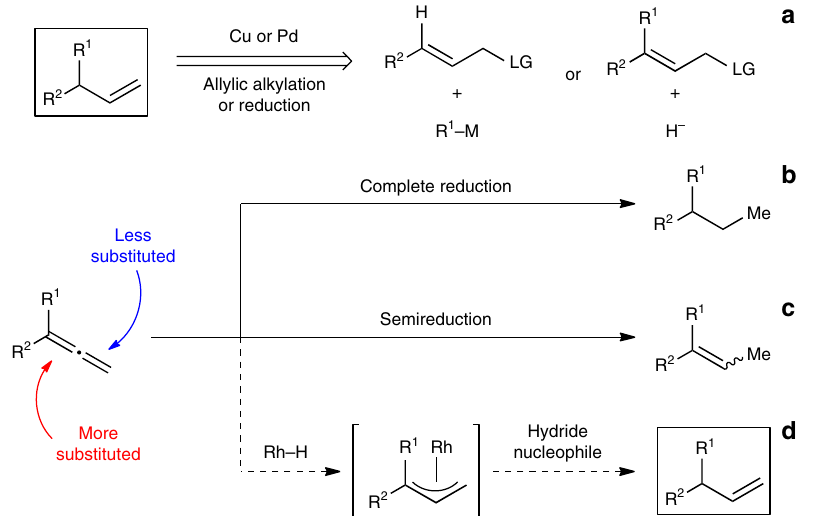
Fig. 1 Challenges in the selective reduction of allenes. a Traditional methods to access chiral allylic motifs. b Complete reduction affords alkanes. c Existing allene semireductions favour formation of the internal alkene. d Proposed strategy for regio- and enantioselective semireduction to afford the complementary terminal alkene